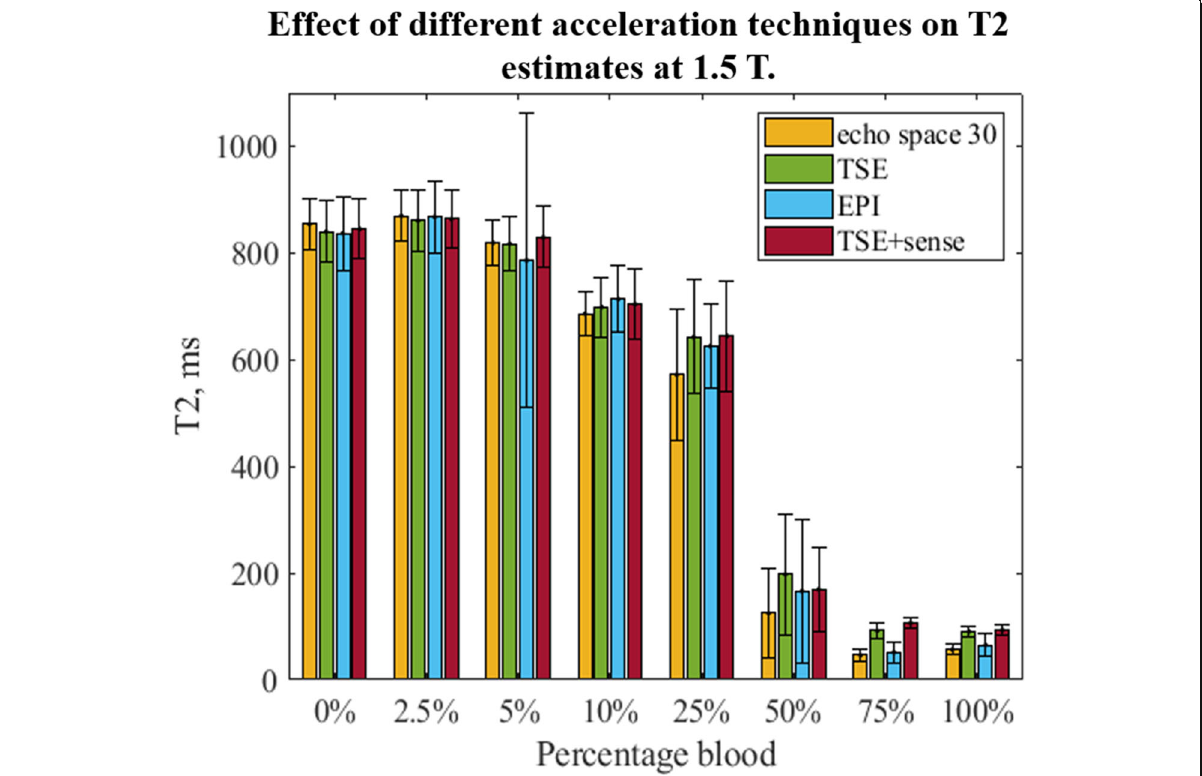
Fig. 3 Effect of different acceleration techniques on T2 estimates at 1.5 T. T2 exhibited an inverse dependence on the blood concentration with all acceleration techniques. The three accelerated T2 mapping methods showed good agreement with the reference scan (echo spacing 30 ms), except from the 5% blood concentration measurement using the EPI acceleration technique. EPI, echo-planar imaging; TSE, turbo spin-echo; TSE+SENSE, turbo spin-echo with sensitivity